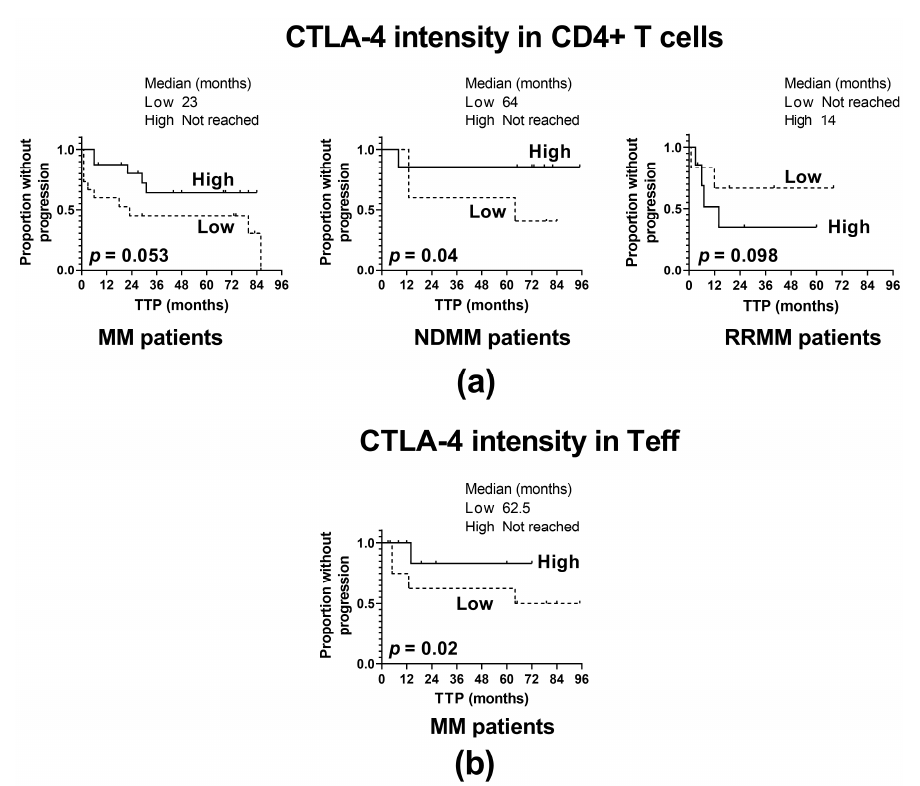
Figure 3. Influence of CTLA-4 expression on the time to progression (TTP). ( a ) TTP in patients with high and low CTLA-4 expression in CD4 + T cells (shown as CTLA-4 fluorescence intensity) identified as > median and ≤ median values, respectively, in the whole patient cohort (MM) (n = 40) and patient subgroups (NDMM and RRMM) (n = 26 and n = 14, respectively). ( b ) TTP in patients with high and low CTLA-4 expression in Teff cells (shown as CTLA-4 fluorescence intensity) identified as >median and ≤ median values, respectively, in the whole patient cohort (MM) (n = 40). The log-rank test was performed for the Kaplan–Meier curves.